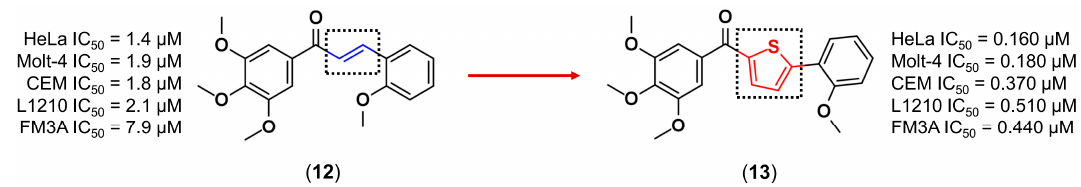
Figure 5. Bioisosterism represented by the replacing the double bond of the enone (blue) with a thiophene (red) [47].